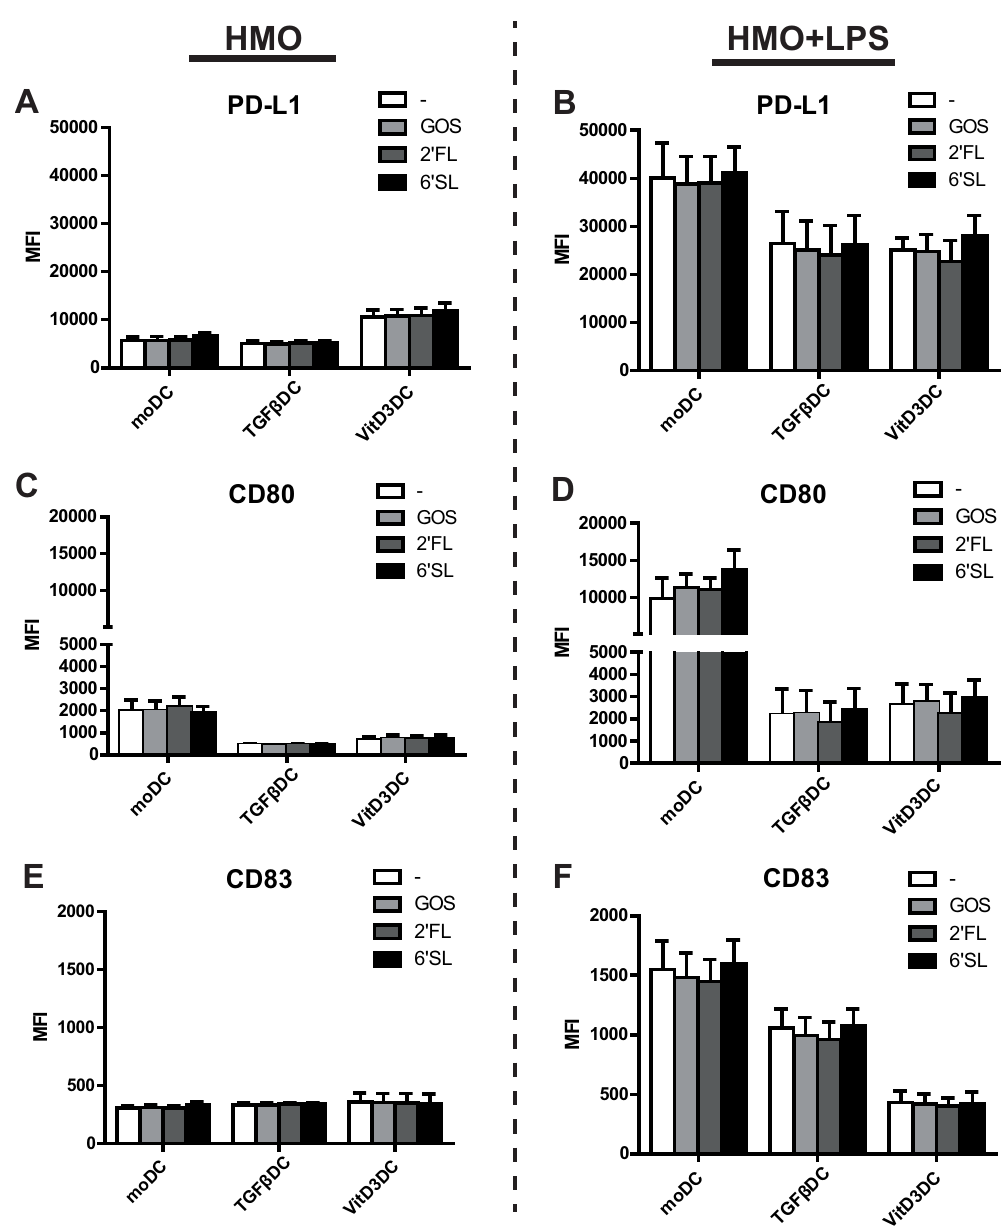
Fig 5. HMOs do not impact maturation of different in vitro generated DC. Immature moDC, TGF β DC and VitD3DC were stimulated with LPS with or without 6’SL, 2’FL or GOS for 48 hours. The effect of 6’SL, 2’FL and GOS was measured in the absence (A, C, F) or presence of LPS (B, D,F). The surface marker expression of A, B) PD-L1 and C, D) CD80 and E, F) CD83 is shown as MFI (median fluorescence intensity) (two independent experiments, six donors).